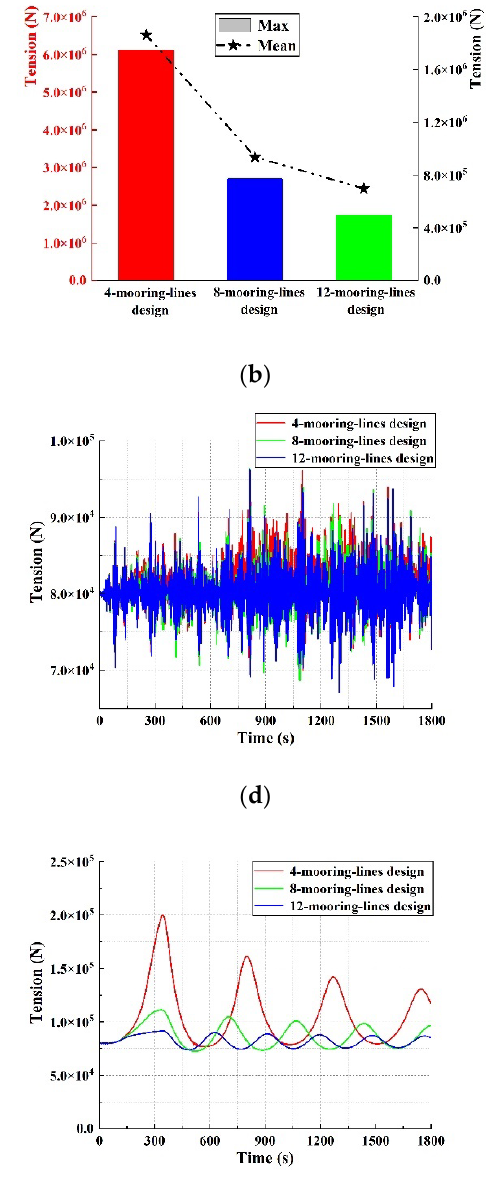
Figure 15. Influence of the number of mooring lines on the mooring system. ( a ) The coupled system for analysis with four mooring lines; ( b ) schematic diagram of the design of four mooring lines; ( c ) the coupled system for analysis with eight mooring lines; ( d ) schematic diagram of the design of eight mooring lines; ( e ) the coupled system for analysis with twelve mooring lines; ( f ) schematic diagram of the design of twelve mooring lines.